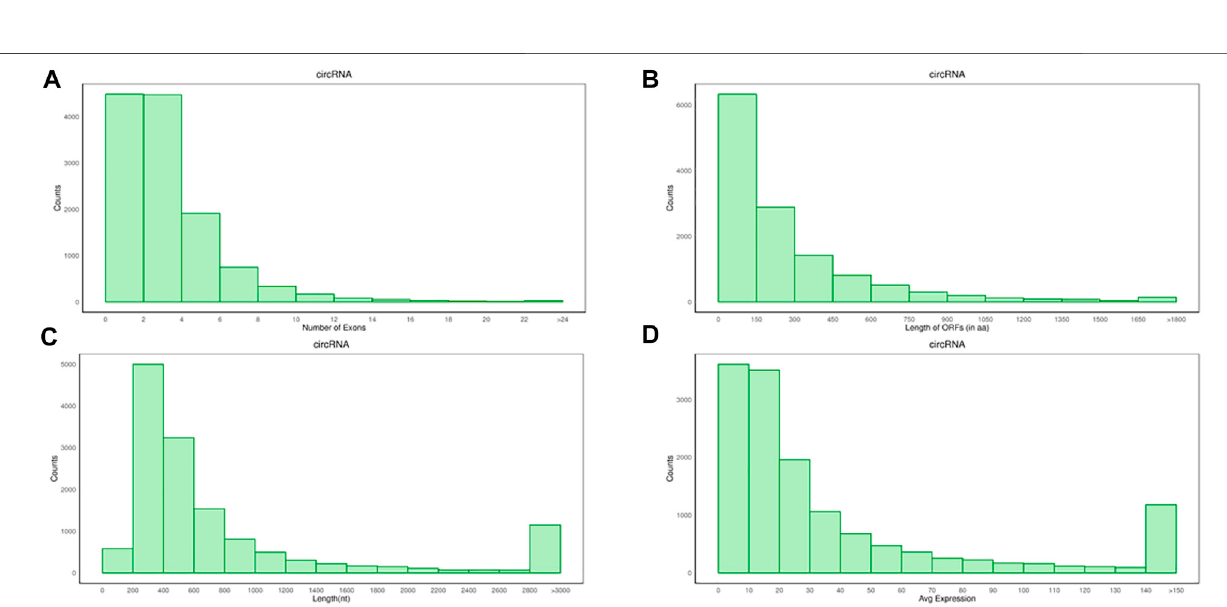
FIGURE 2 | Analysis of genomic characteristics on circRNAs. (A) Number of circRNAs exons. (B) Length of circRNAs ORF. (C) Transcript length of circRNAs. (D) The expression levels of circRNAs.